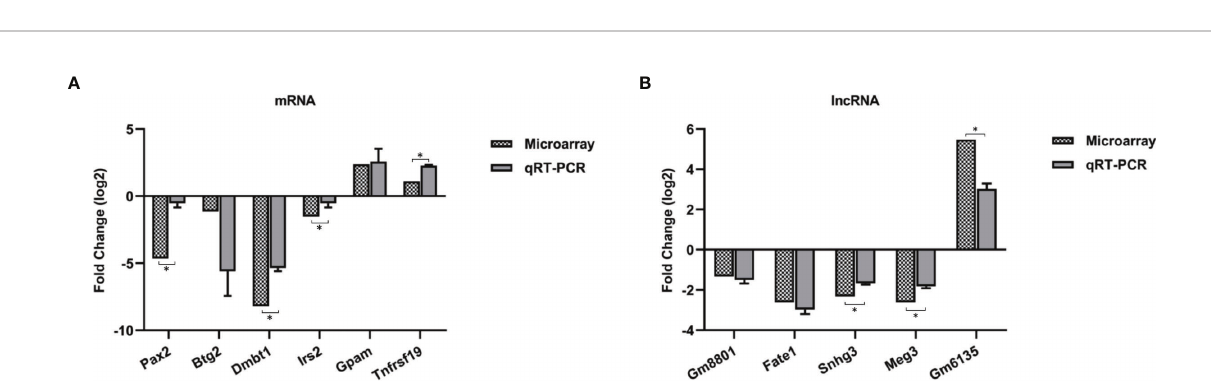
FIGURE 2 | Hierarchical clustering of differentially expressed mRNAs (A) and lncRNAs (B) in the liver with C. sinensis infection. Blue indicates decreased relative expression, and red indicates increased relative expression.